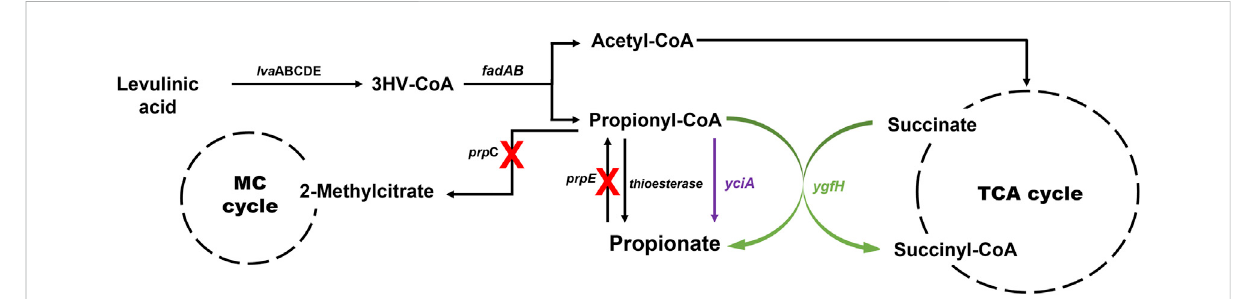
FIGURE 3 Metabolic pathway involved in PA production from LA in P. putida . The yciA (encoding thioesterase from H. in fl uenzae ) and ygfH (encoding propionyl-CoA: succinate CoA transferase from E. coli ) were overexpressed, and the prpC and prpE genes encoding methylcitrate synthase and propionyl-CoA synthase, respectively, were deleted. MC cycle, methylcitrate cycle; TCA cycle, tricarboxylic acid cycle; lvaABCDE , lva operon of P. putida involved in LA